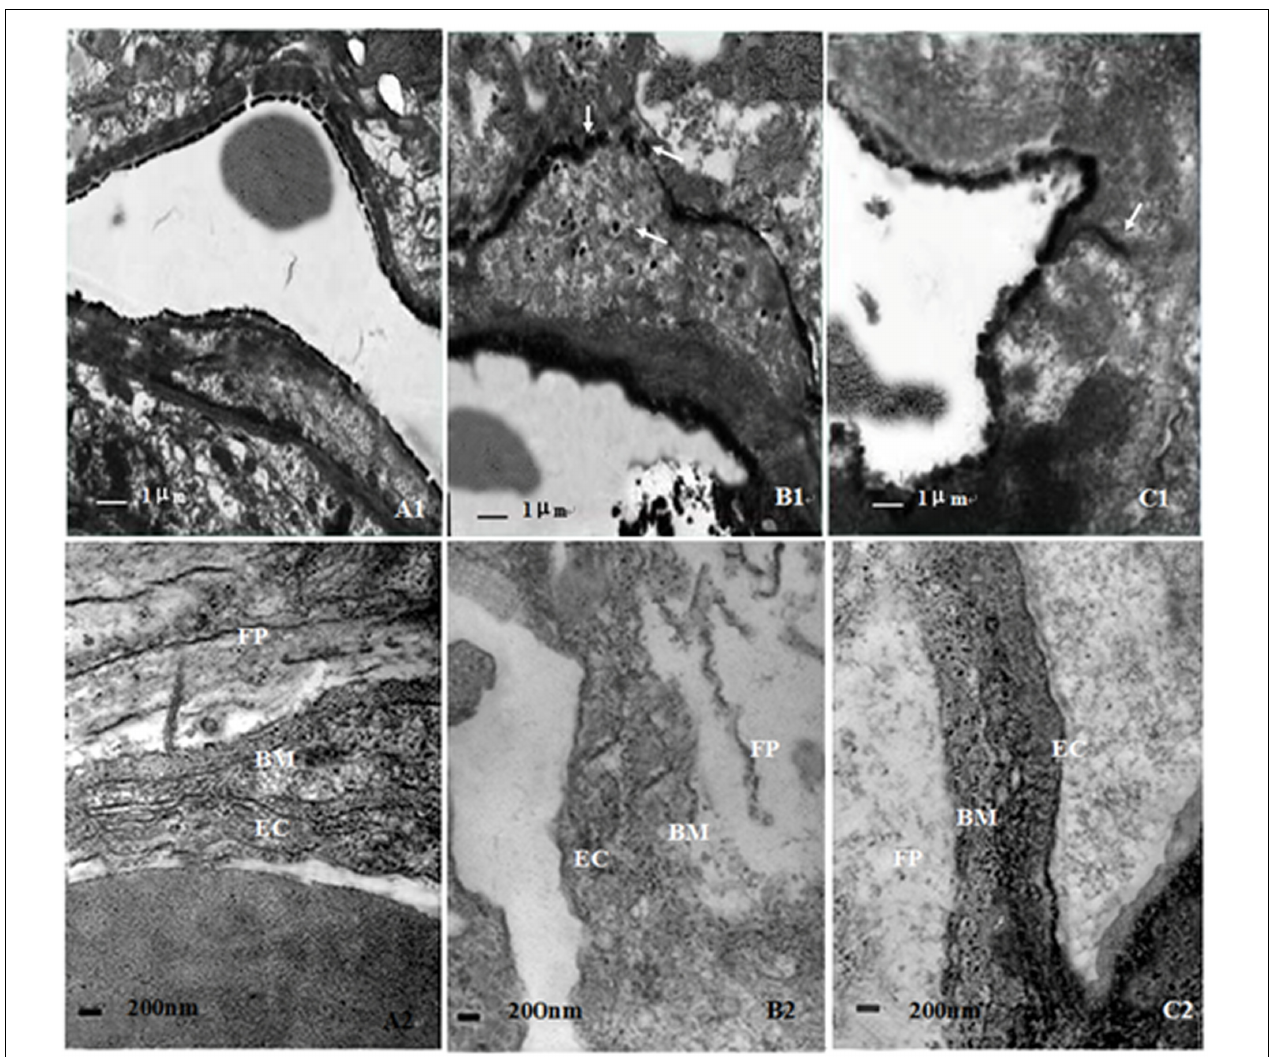
FIGURE 3 | Ultrastructure changes of blood–brain barrier in different groups. The structure of BBB was relatively intact in NC group, and lanthanum nitrate particles were confined within the microvessel walls (A1,A2). However, the structural integrity of vascular walls was seriously destroyed in CO group, and lanthanum nitrate particles were penetrated from vessel walls into brain parenchyma (B1,B2). By contrast, the ultrastructural damage of microvessels was not serious in NBP treatment group, only a small part of lanthanum particles passed through the vessel wall and leaked into brain parenchyma (C1,C2). Arrows: lanthanum nitrate particles; Bm: basement membrane; Ec: endothelium cell; Fp: foot process; RBC: red blood cell (Scale bar is 1 µ m in A1,B1,C1, and 200 nm in A2,B2,C2; n =